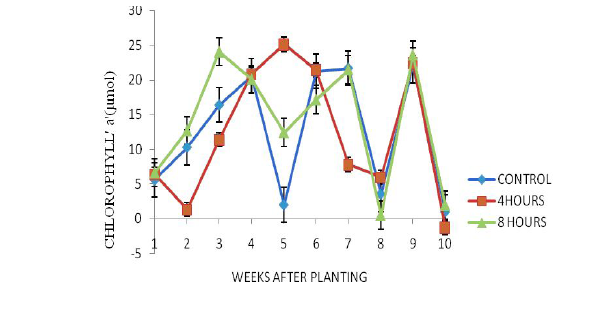
Fig. 5. Effect of prior heat stress on the accumulation of chloro- phyll a in C. papaya